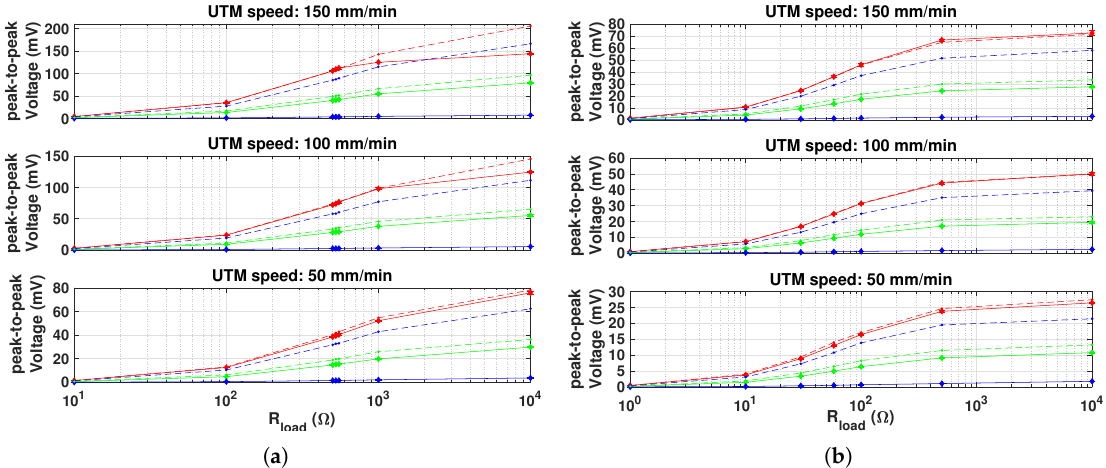
Figure 13. Comparison between the peak-to-peak measured (diamonds with solid line) and simulated (dots with dashed line) voltage vs. the applied electric load. PMs with different diameters are considered—10 (green), 15 (red) and 20 mm (blue). ( a ) Coils connected in series. ( b ) Coils connected in